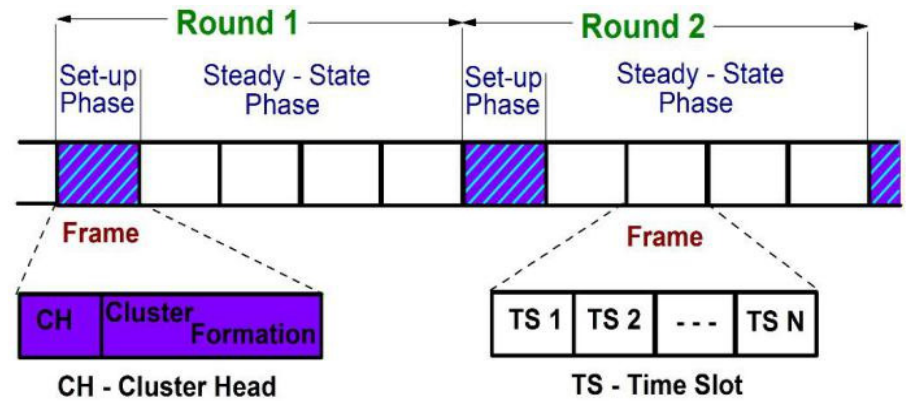
Figure 8. Phases of LEACH protocol .